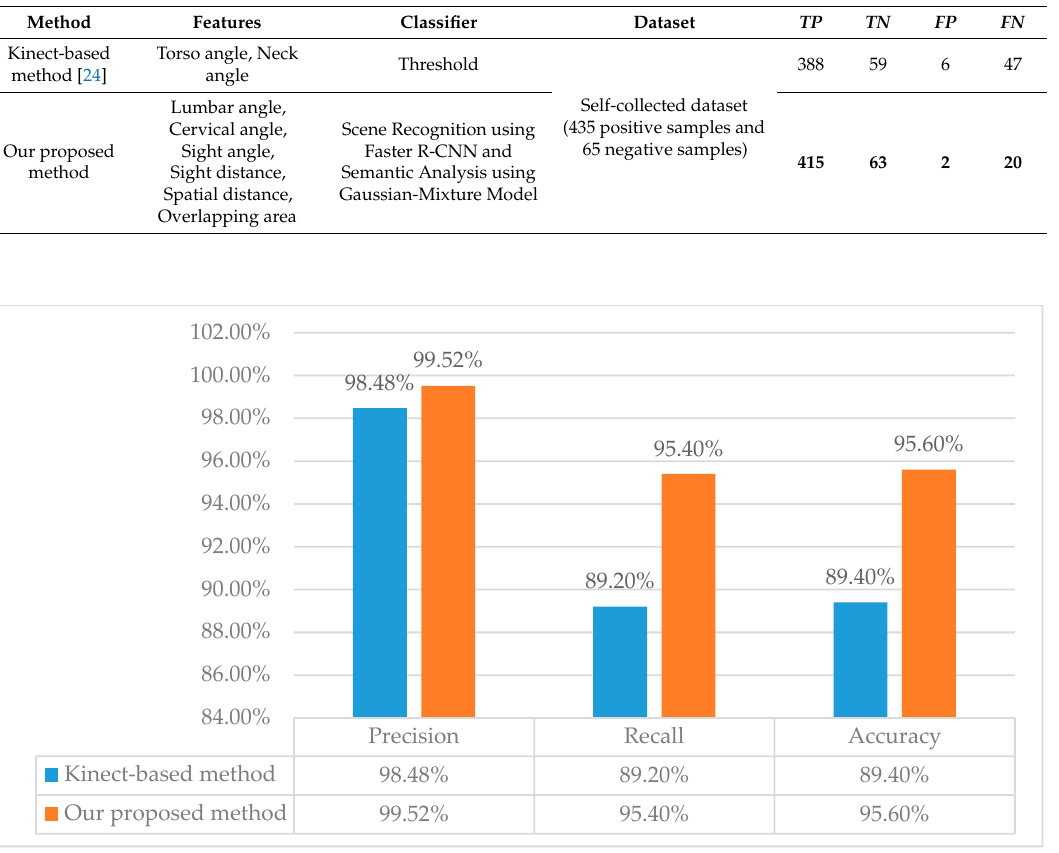
Figure 11. Comparison of our method and the Kinect-based method about precision, recall and accuracy based on self-collected dataset.